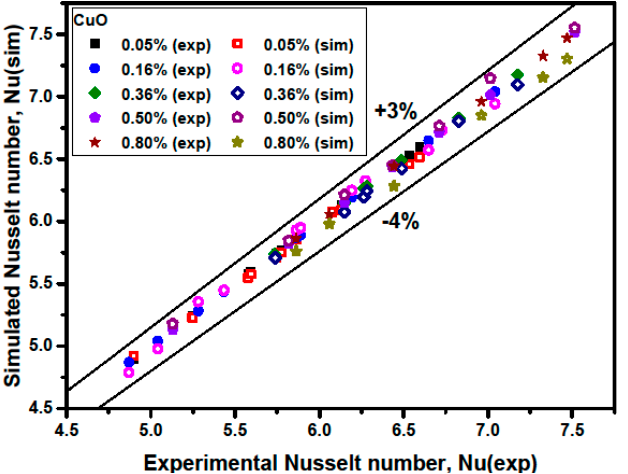
Figure 11. Comparison of measured and predicted Nusselt number for CuO/water nanofluids.